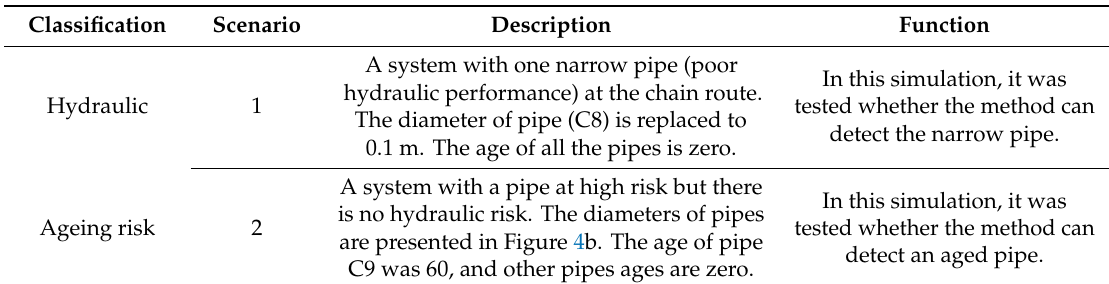
Table 3. The simulation